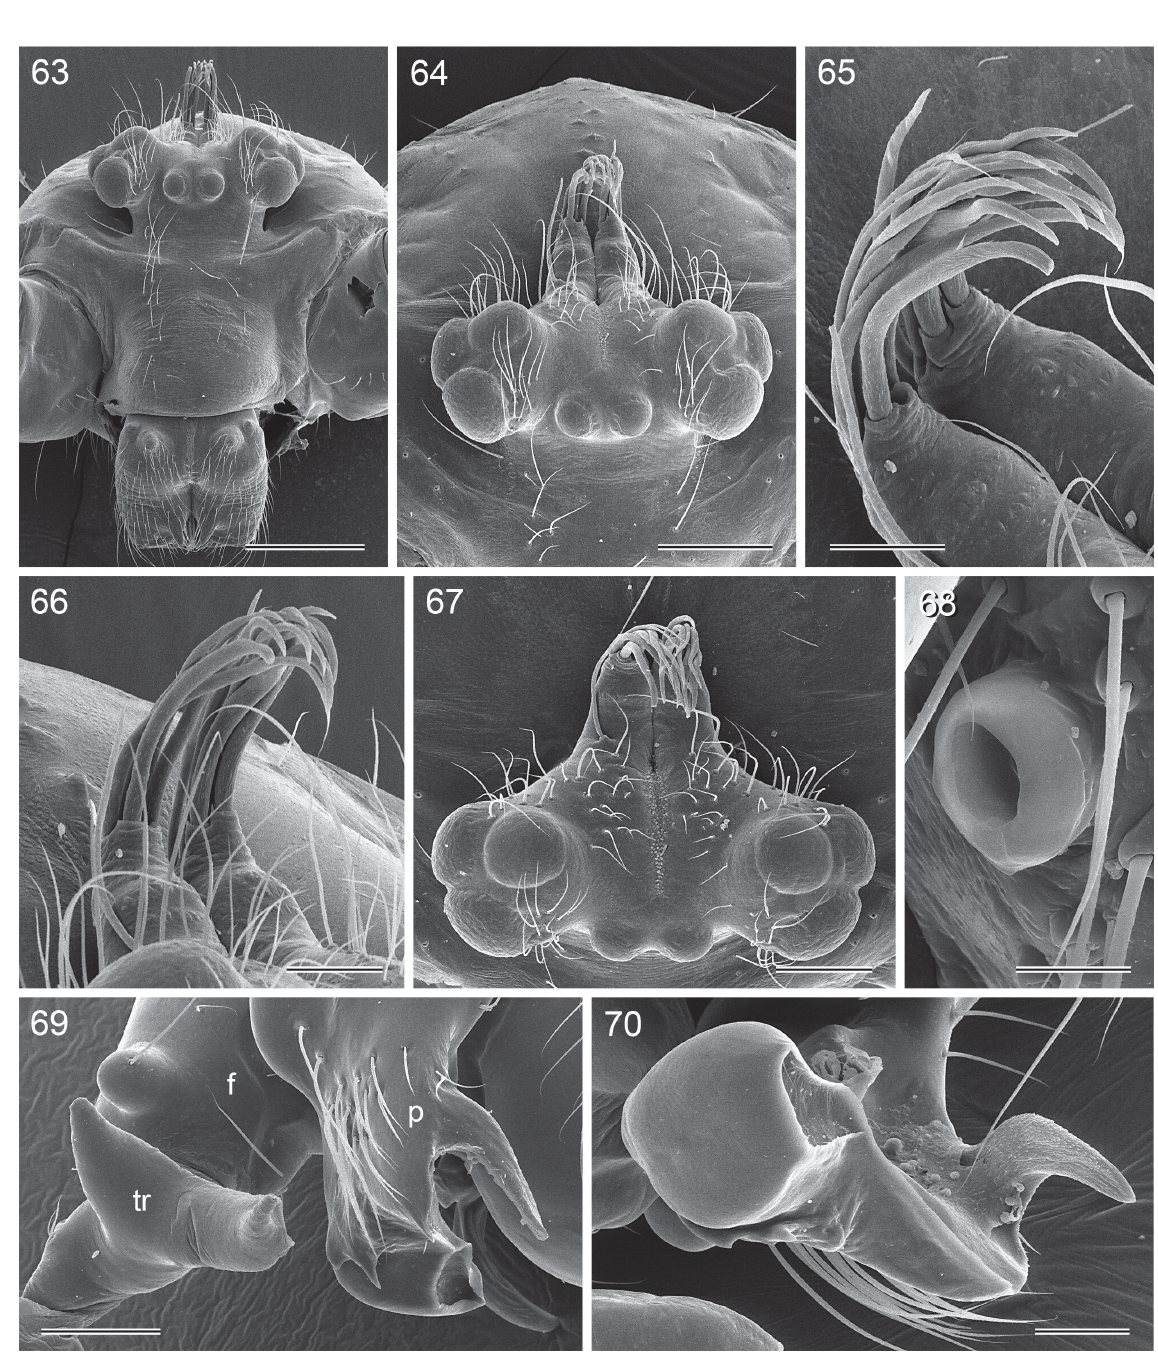
Figs 63–70. Pholcus baguio Huber, sp. nov., ZFMK Ar 15507. 63 . Male prosoma, frontal view. 64 . Male ocular area, frontal (slightly dorsal) view. 65–66 . Male ocular horns and modified hairs. 67 . Male ocular area, dorsal view. 68 . Male left palpal tarsal organ. 69 . right male palpal trochanter and procursus, retrolatero-dorsal view. 70 . Left procursus, distal view. Scale lines: 63 = 500 µm; 64 = 300 µm; 65 = 80 µm; 66, 70 = 100 µm; 67, 69 = 200 µm; 68 = 30